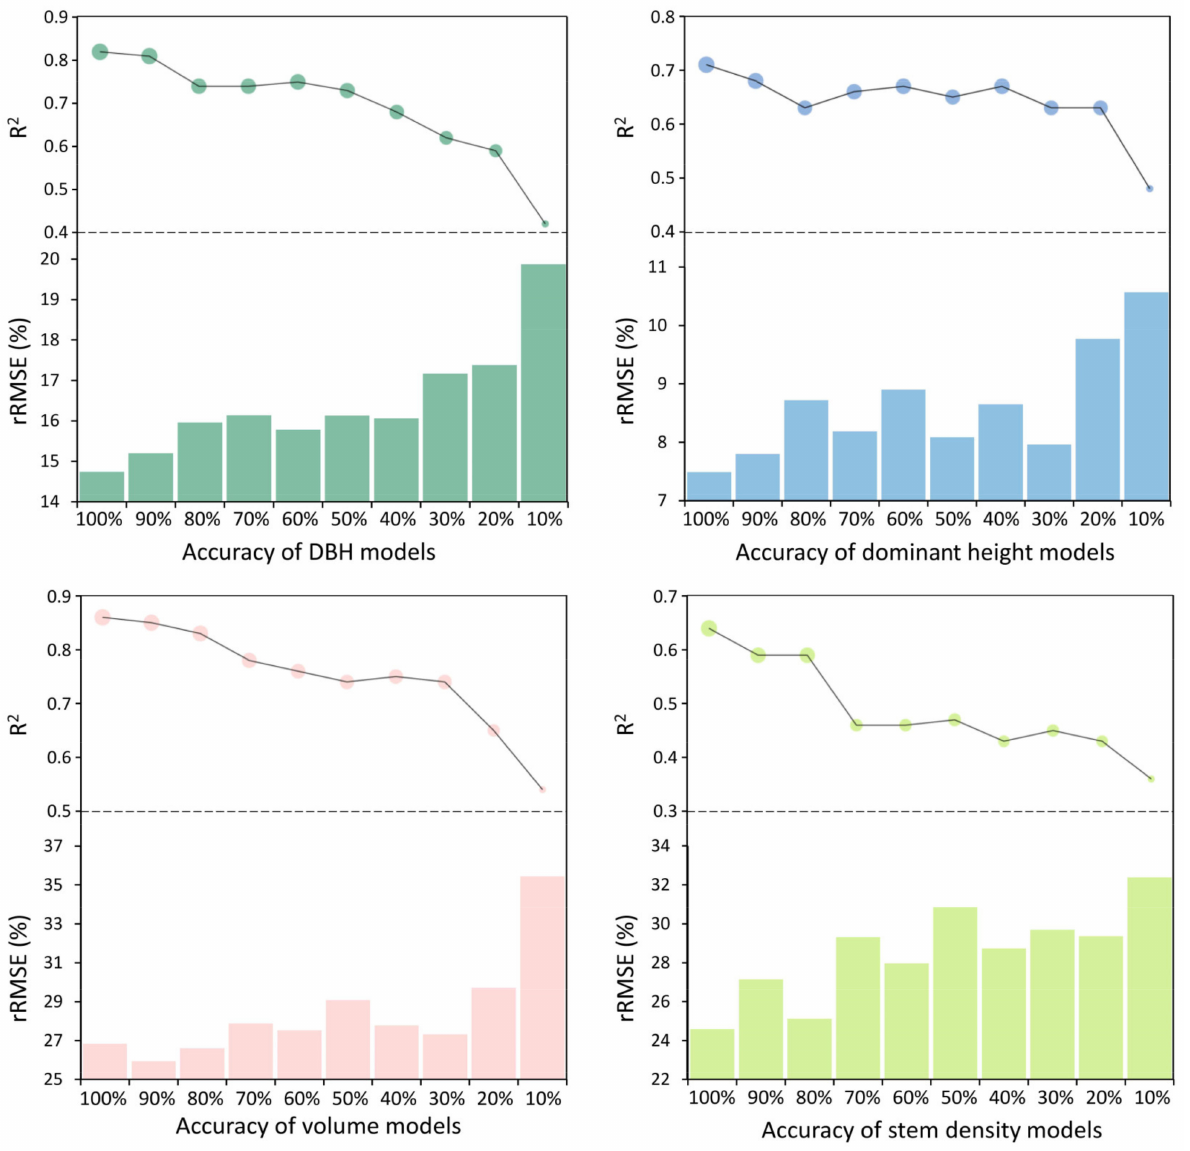
Figure 8. Sensitivity analysis of estimation results by reducing UAV-LiDAR sampling